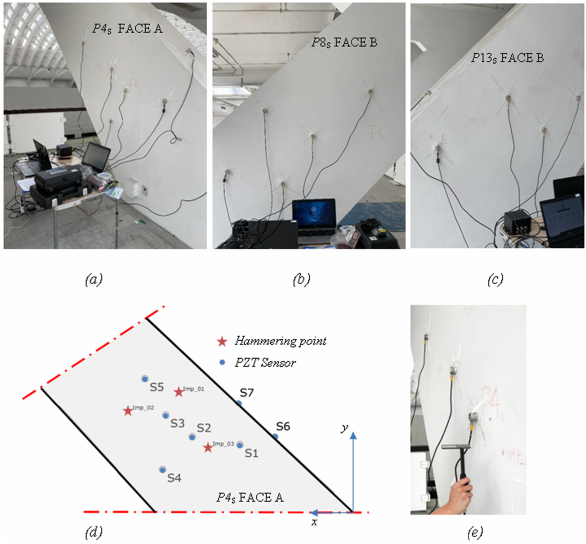
Figure 5: Application of the sensor array to the slant pillar (a) P4 S , (b) P8 , (c) P13 . (d) Detail of the sensor positions for P4 S S